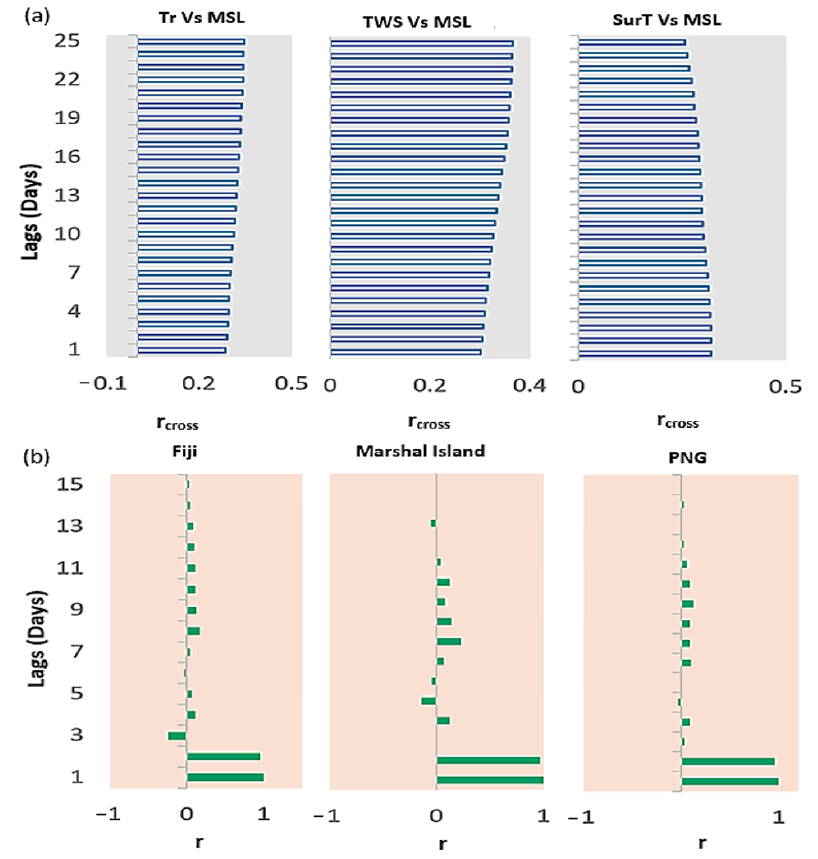
Figure 3. ( a ) Correlogram showing the covariance between the objective variable (MSL) and the predictor variables in terms of the cross-correlation coefficient ( r cross ) for Fiji stations and ( b ) Partial Auto Correlation Function (PACF) plot of the MSL time series exploring the antecedent behaviour in terms of the lag of MSL for every day (TWS — Terrestrial Water Storage, Tr — Transpiration, SurT — Average Surface Skin Temperature).